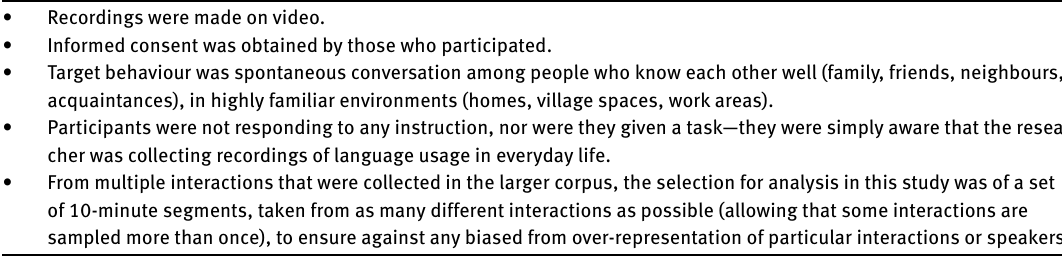
Table 1: Key properties of the data collected for the studies in this